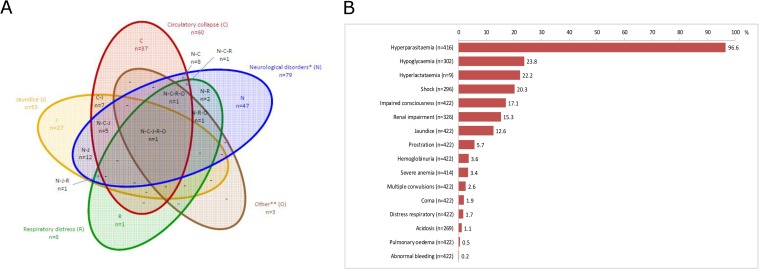
Distribution of the 2000 WHO criteria for severity in 422 children admitted for severe imported malaria in mainland France, 1996–2005 (Fig 3A). Prevalence and overlap of the WHO clinical criteria at admission in 422 children with severe imported malaria in mainland France, 1996–2005 (Fig 3B).